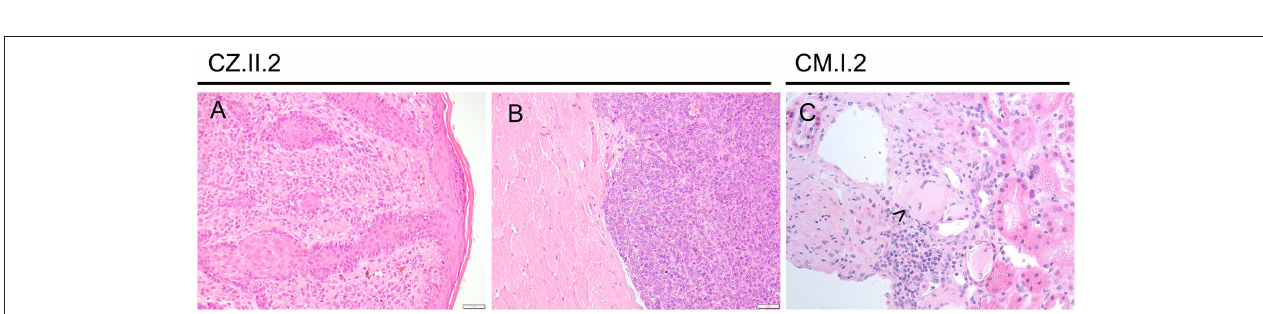
FIGURE 3 | Gastric cancer and precursor lesions in CTLA-4-insufficient-patients. (A) Poorly differentiated EBV associated adenocarcinoma at the age of 41 years (inlet displays chromogen in situ hybridization of EBV coded mRNA/EBER ISH). (B) Same patient at the age of 44 years with a well-differentiated EBV associated adenocarcinoma (inlet with EBER ISH). (C) Infiltration of the lamina propria through discohesive carcinoma cells in a 25-years-old patient. (D-F) 34-years-old patient with small poorly differentiated adenocarcinoma ( D ,e for macroscopy; E for histology) and larger well-differentiated adenocarcinoma ( D ,f for macroscopy; F for histology). (G,H) Pyloric biopsies taken at the age of 43 years showing high grade dysplasia (G) and viral inclusions ( H , highlighted by arrowhead).